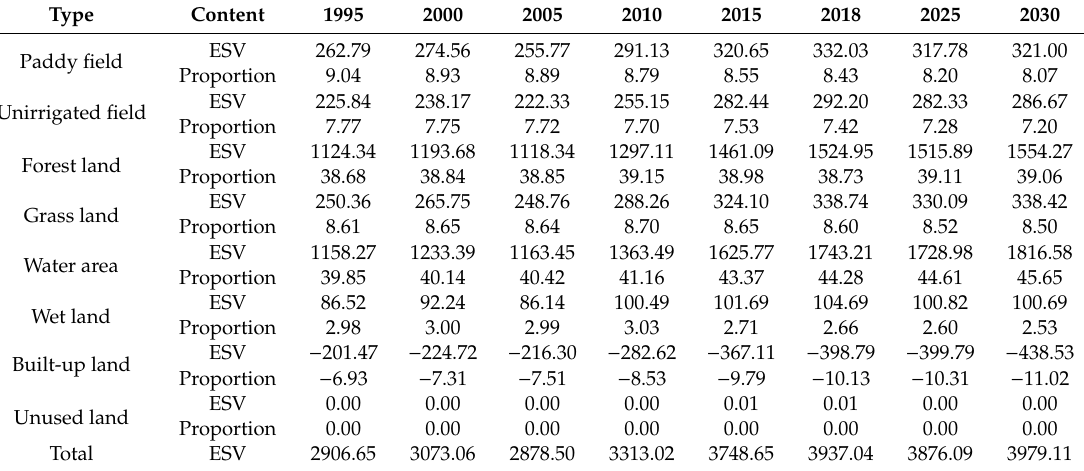
Table 14. ESV estimation results of Anhui Province (Unit: 10 7 USD,